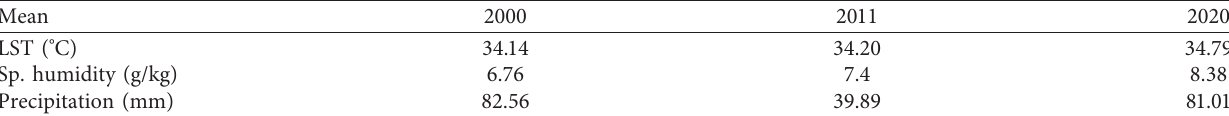
Table 8: Statistics comparison table for climatological parameters for 2000, 2011, and